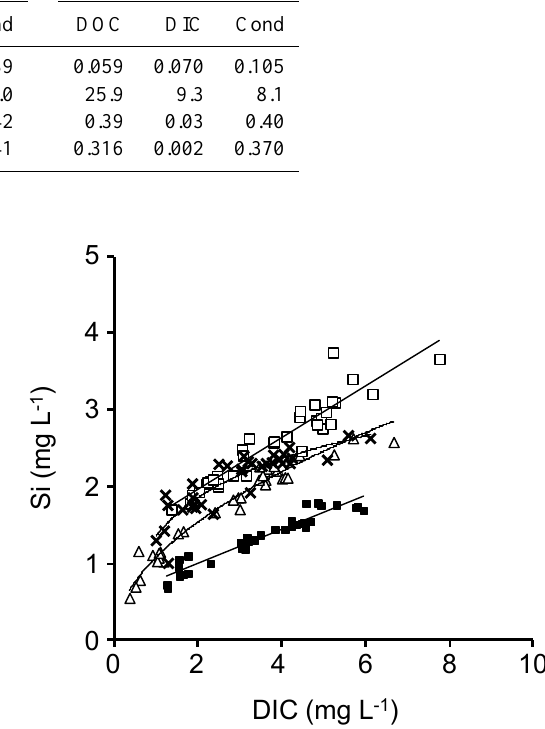
Fig. 3. The relationship between stream water concentrations of dis- solved silica (Si) and DIC in stream 1 (open squares; r 2 = 0 . 90, p < 0 . 001, linear), stream 2 (crosses; r 2 = 0 . 77, p < 0 . 001, logarit- mical), stream 4 (open triangles; r 2 = 0 . 95, p < 0 . 001, power), and stream 5 (filled squares; r 2 = 0 . 89, p > 0 . 001, linear). The relation- ships were best explained by either linear or curve–linear